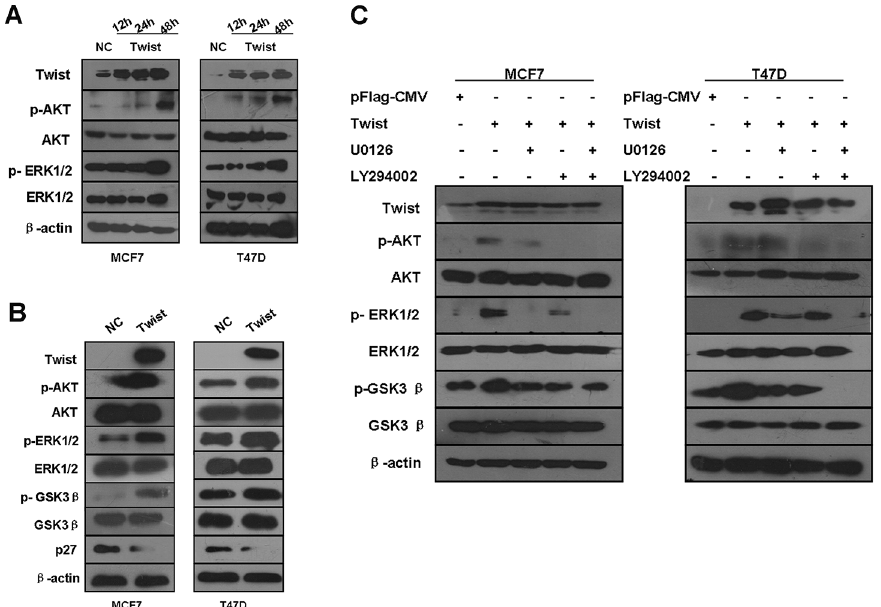
Fig 4. Overexpressed Twist activates Akt and ERK signaling pathways. (A) MCF-7 (left panel) and T47D (right panel) cells were transiently transfected with empty vector pFlag-CMV and pFlag-Twist, and then subjected to western blot analysis with enumerative antibodies. β -actin was used as loading control. When looked at the time course of ERK and Akt phosphorylation, the p-Akt, p-ERK expression started to increase in both MCF-7 and T47D cells at 12 or 24h after transfection with pFlag-Twist, but no change on total ERK and Akt proteins. The phosphorylation of Akt and ERK reached the highest level at 48 h in both MCF7 and